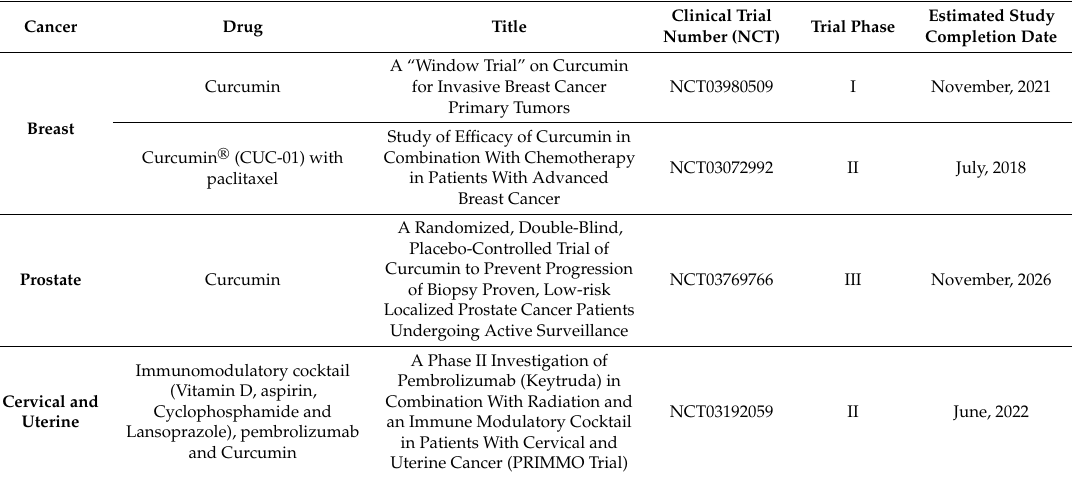
Table 2. The most recent clinical trials with